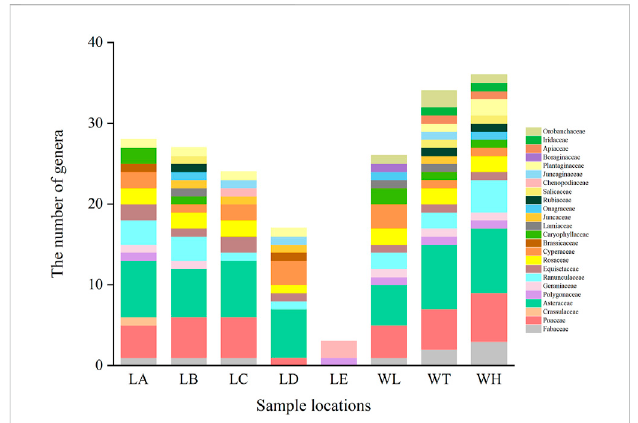
Distribution types and numbers of fl ora families and genera in wetlands along the riparian zone of the Ulgai River. LA, source area; LB, upper reaches; LC, middle reaches; LD, lower reaches; LE, terminal lake; WL, low fl oodplain; WT, transition zone; WH, high fl oodplain. The same is following Figures and